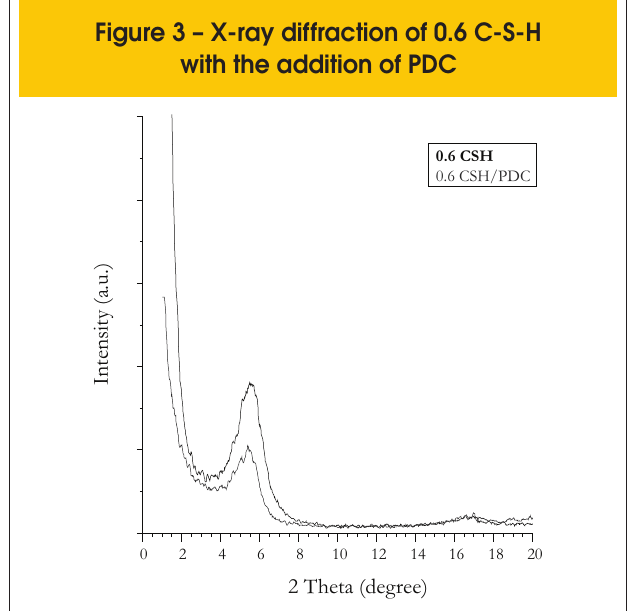
Figure 3 – X-ray diffraction of 0.6 C-S-H with the addition of PDC